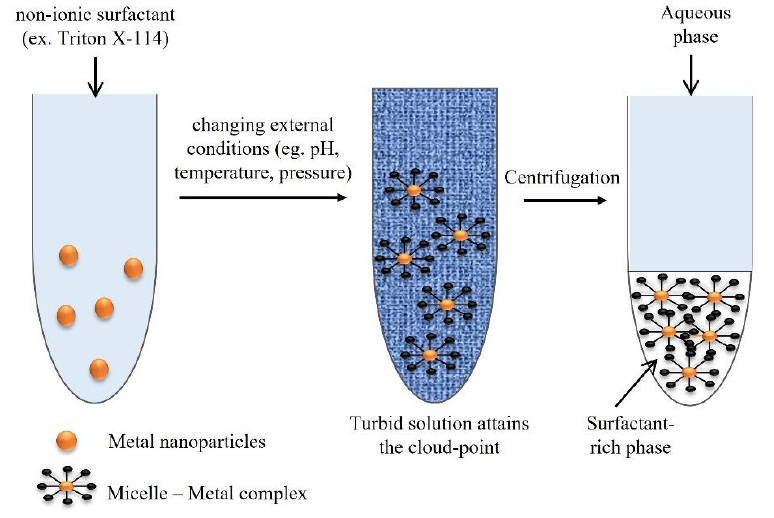
Figure 8. Representative scheme of CPE protocol.